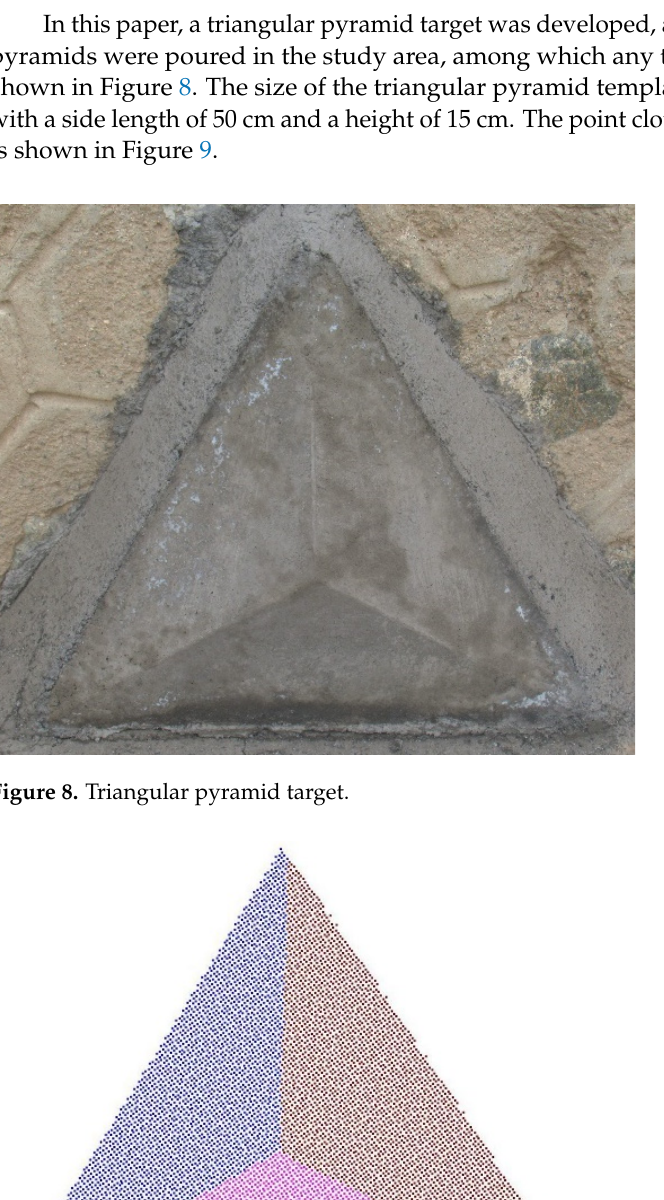
Table 4. The coordinates of control